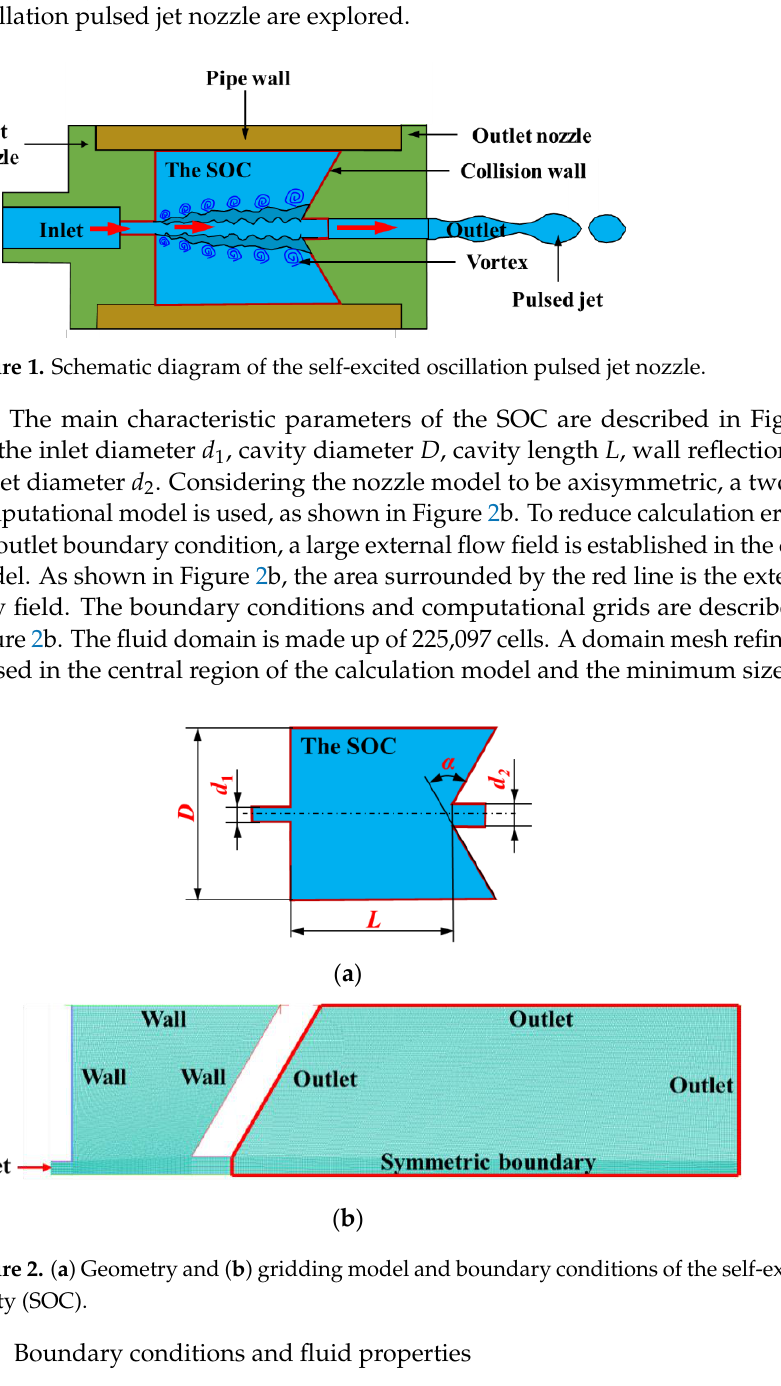
Figure 2. ( a ) Geometry and ( b ) gridding model and boundary conditions of the self-excited oscillation cavity (SOC).